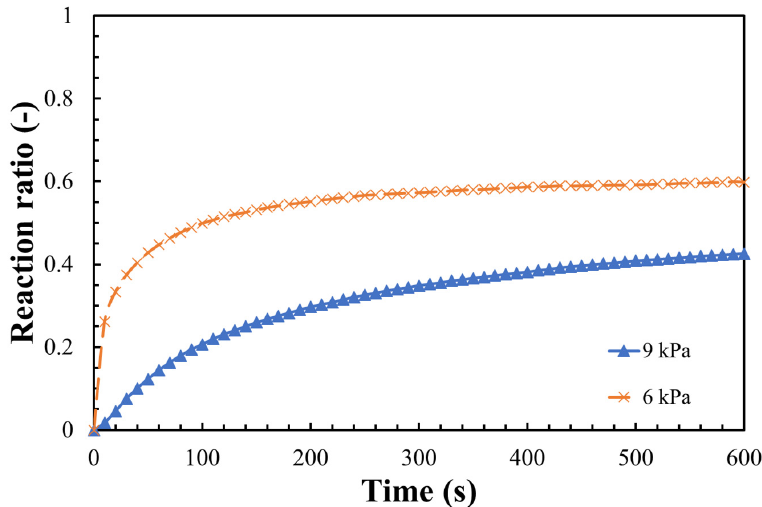
Figure 7. E ff ect of the particle size on the hydration reaction rate (conditions A and D). Figure 7. Effect of the particle size on the hydration reaction rate (conditions A and D).